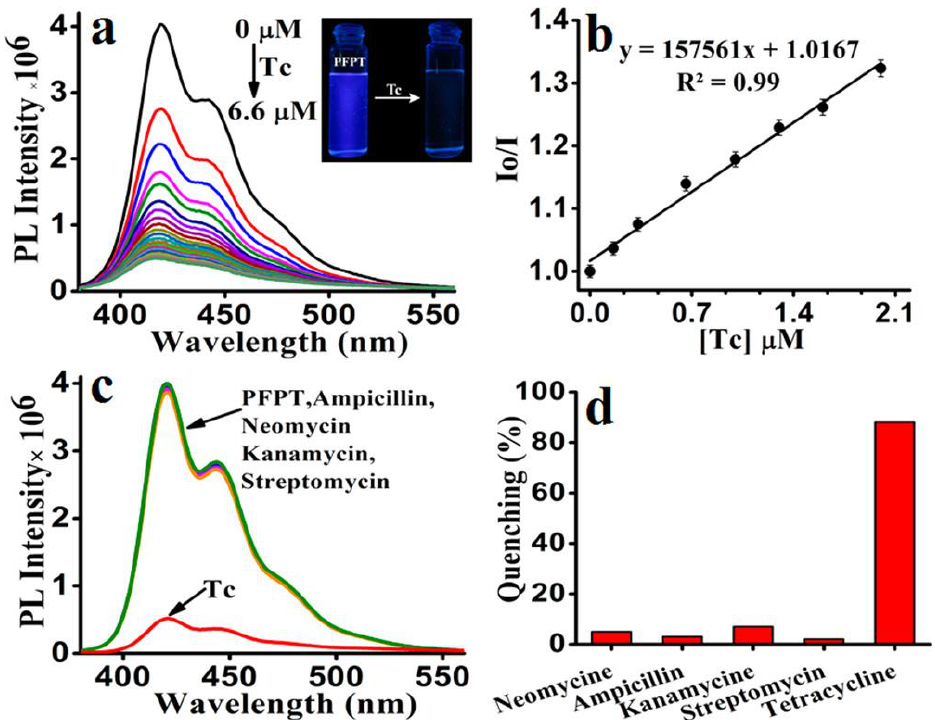
Figure 15. ( a ) Fluorescence spectra of PFPT (6.6 µ M) with increasing concentration of Tc (6.6 µ M) in aqueous media (HEPES 10 mM, pH 7.4). Inset: color change of PFPT under UV light (lamp excited at 365 nm) before and after adding Tc. ( b ) Stern–Volmer plot of PFPT upon the addition of Tc in aqueous media. Effect of Tc (6.6 µ M) and various other antibiotics (6.6 µ M) on the ( c ) emission spectra of PFPT and their corresponding ( d ) bar diagram depicting the quenching percentage. Reproduced with permission from reference [121]. Copyright 2017, American Chemical